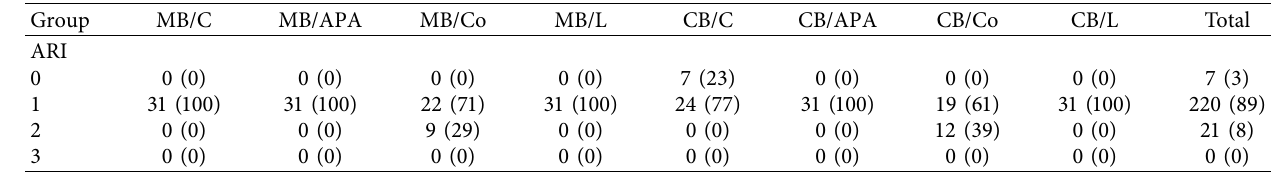
Table 3: Frequency distribution (percentage) of adhesive remnant index (ARI) scores in the study groups. Group